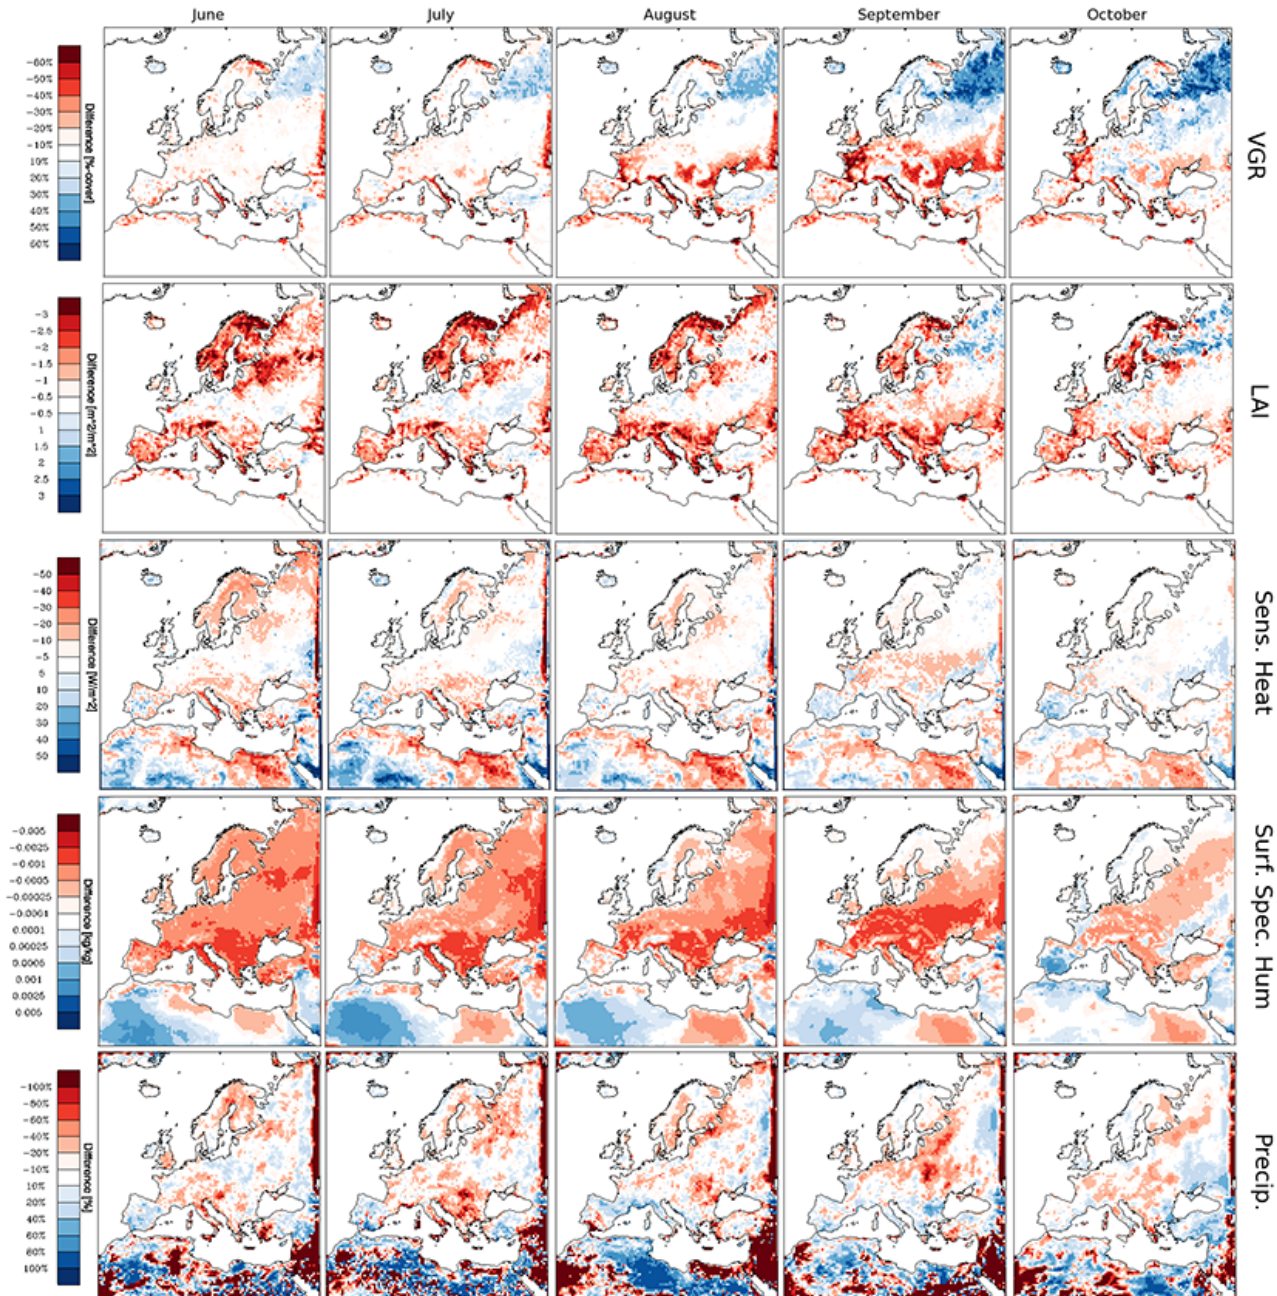
Figure 9. Differences in model parameters (LAI, vegetation ratio (VGR), sensible heat flux, surface specific humidity, precipitation) from June to